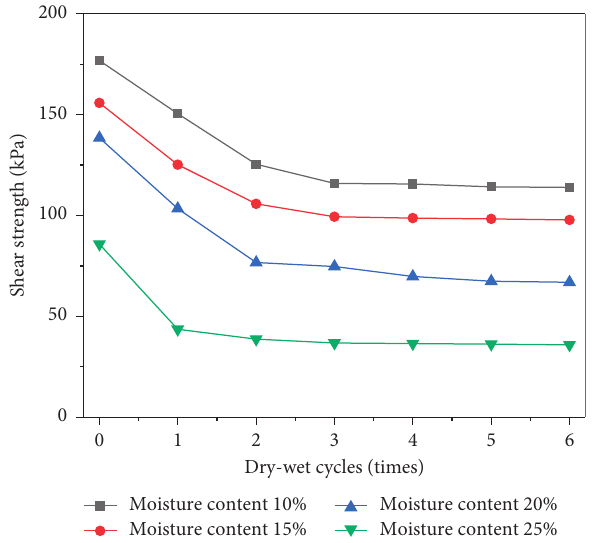
Figure 11: Relationship between shear strength τ and cycle times of the Luochuan soil samples with different water contents when Δ w �